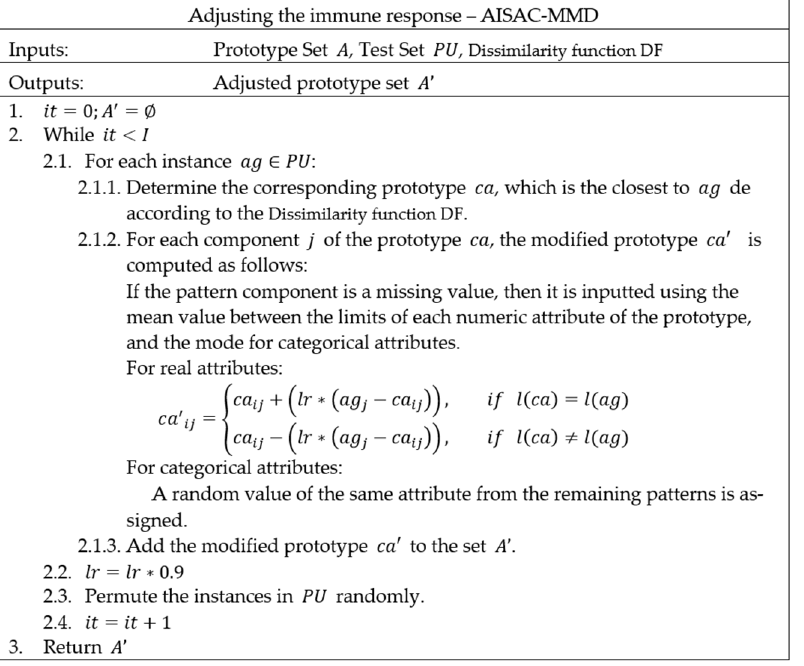
Figure 4. Pseudocode of the adjustment in the adaptive immune response in the AISAC-MMD model.